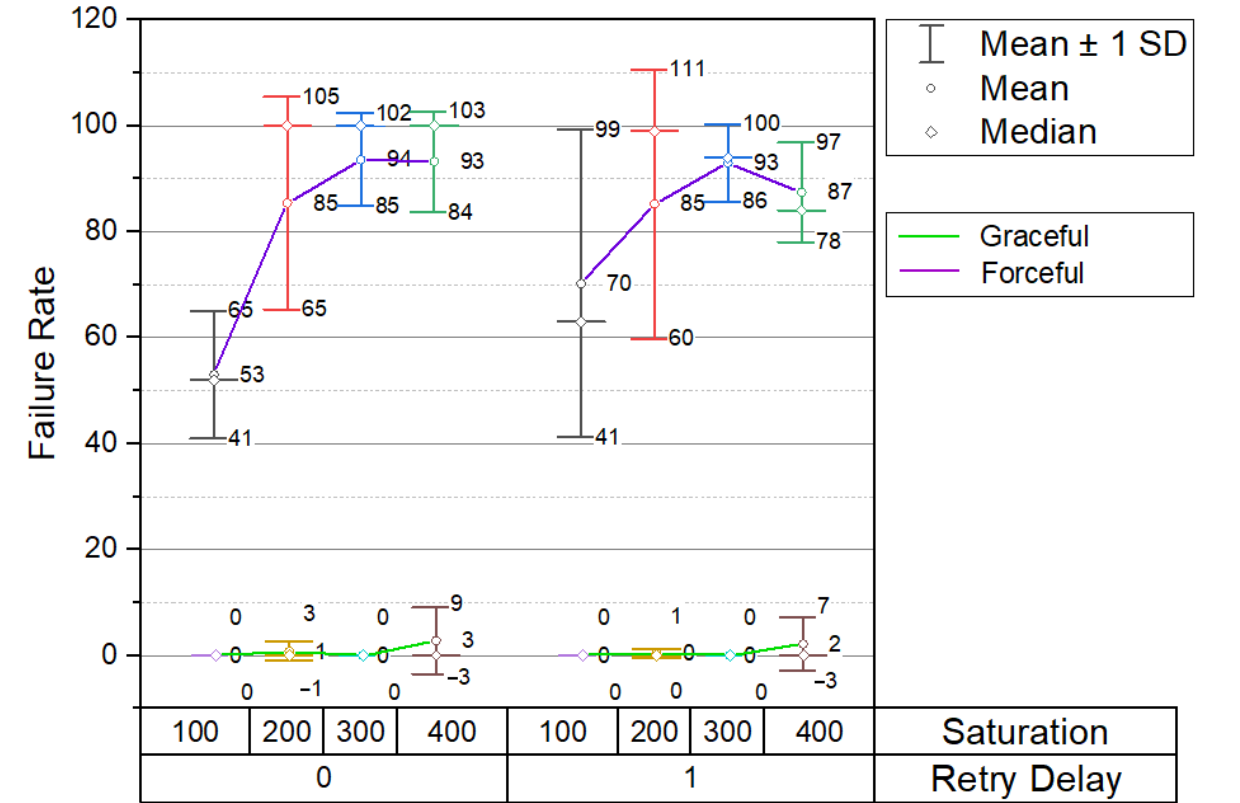
Figure 5. Dependency of failure rate on failover method, saturation and retry delay.